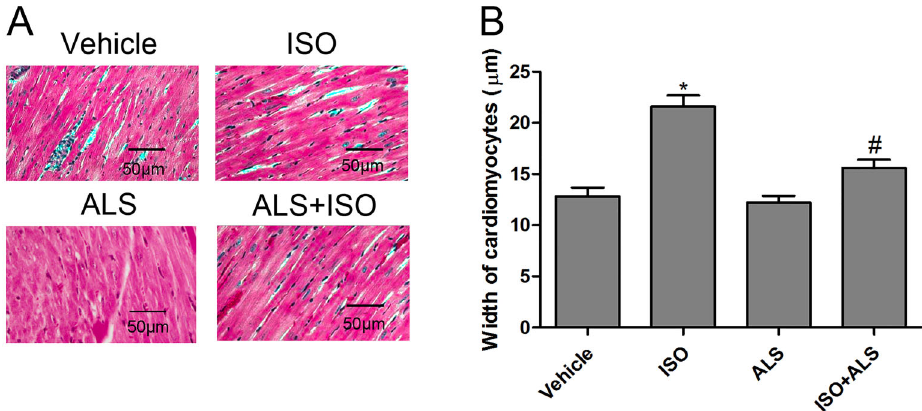
Figure 1. Effect of aliskiren (ALS) on cardiomyocyte size in isoproterenol (ISO)-treated rats. A , Hematoxylin and eosin staining was performed and ( B ) the width of cardiomyocytes was measured (n=6 per group). Data are reported as means ± SE. *P o 0.05 compared with vehicle; # P o 0.05 compared with the ISO-treated group (ANOVA followed by Tukey ’ s post hoc